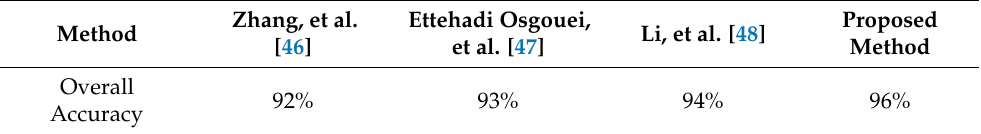
Table 8. Comparison of the built-up area detection methods in terms of